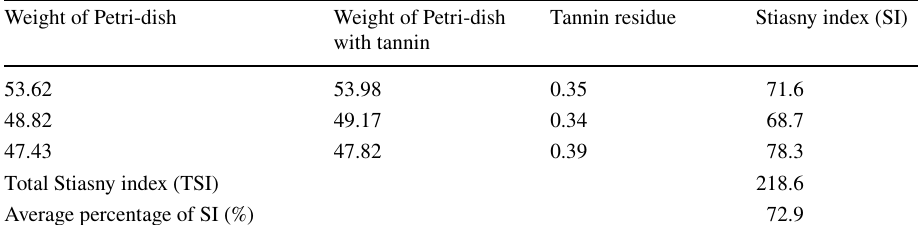
Weight of Petri-dish